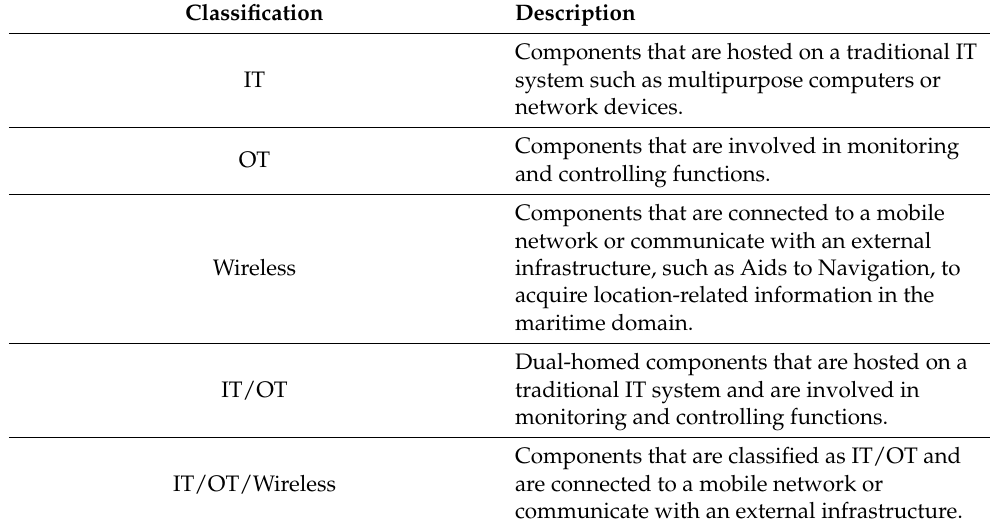
Table 1. Component classification by method